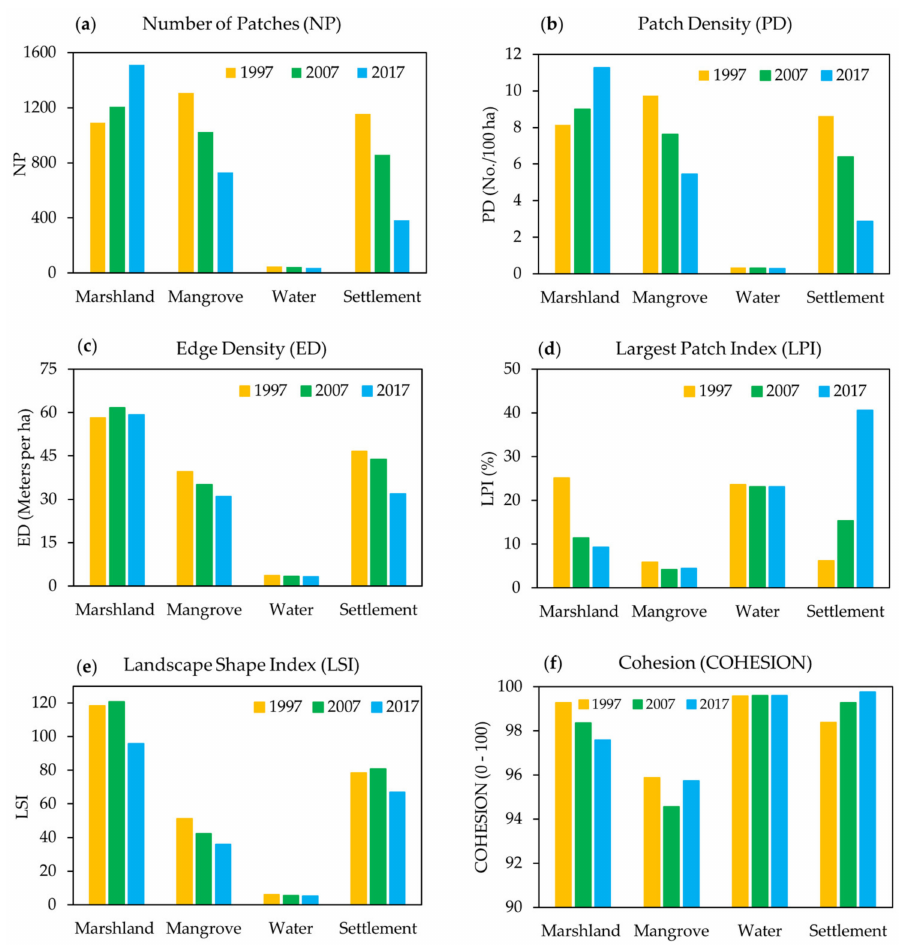
Figure 7. Class-level spatial metrics for the MMNL (1997–2017).